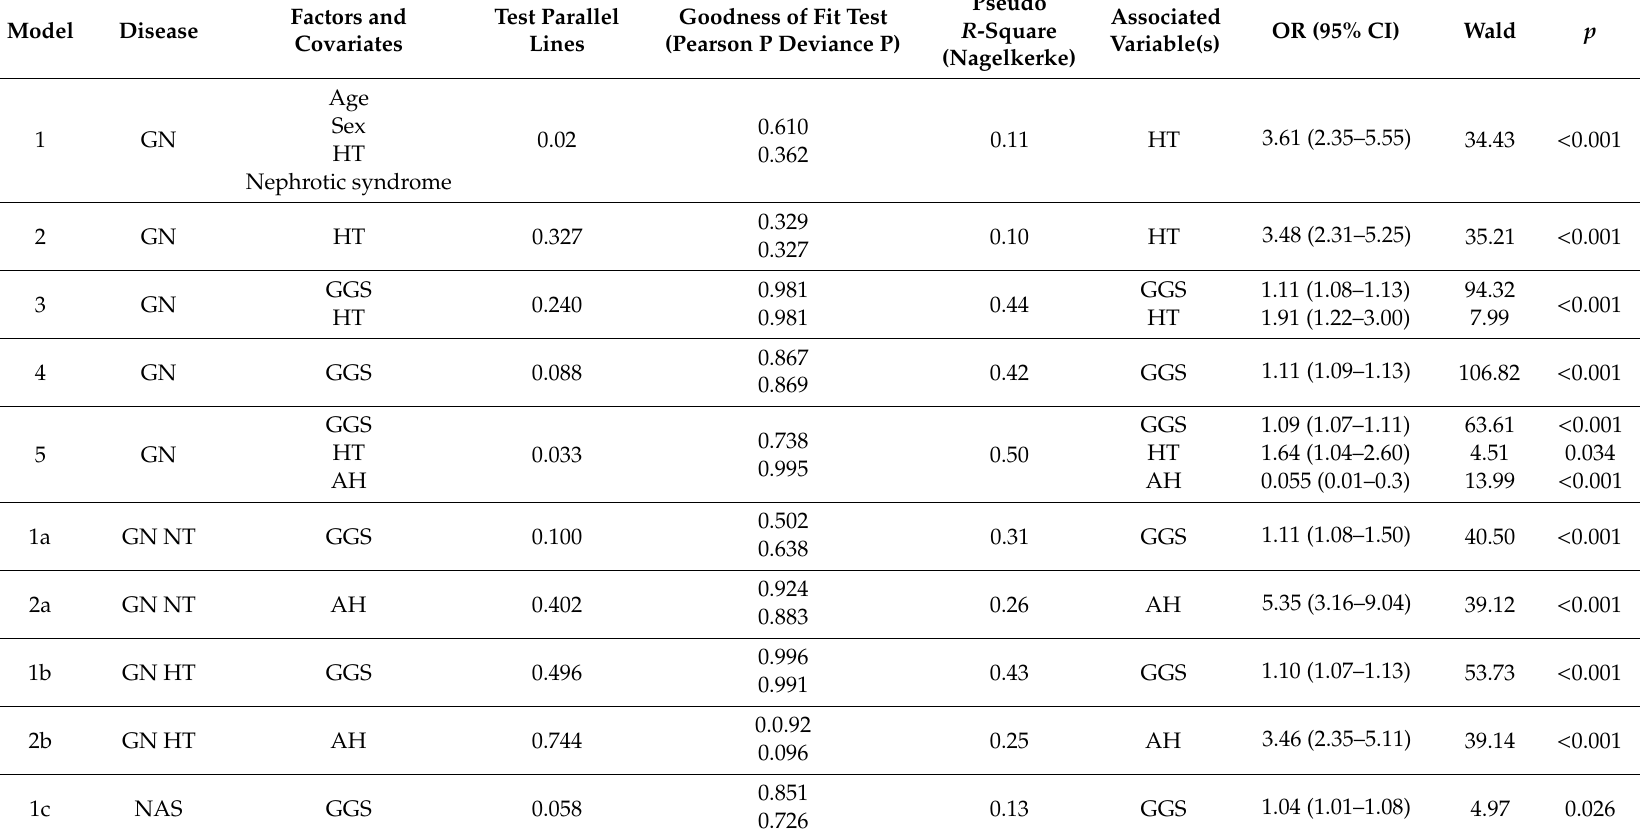
Table 3. Ordinal regression analysis in